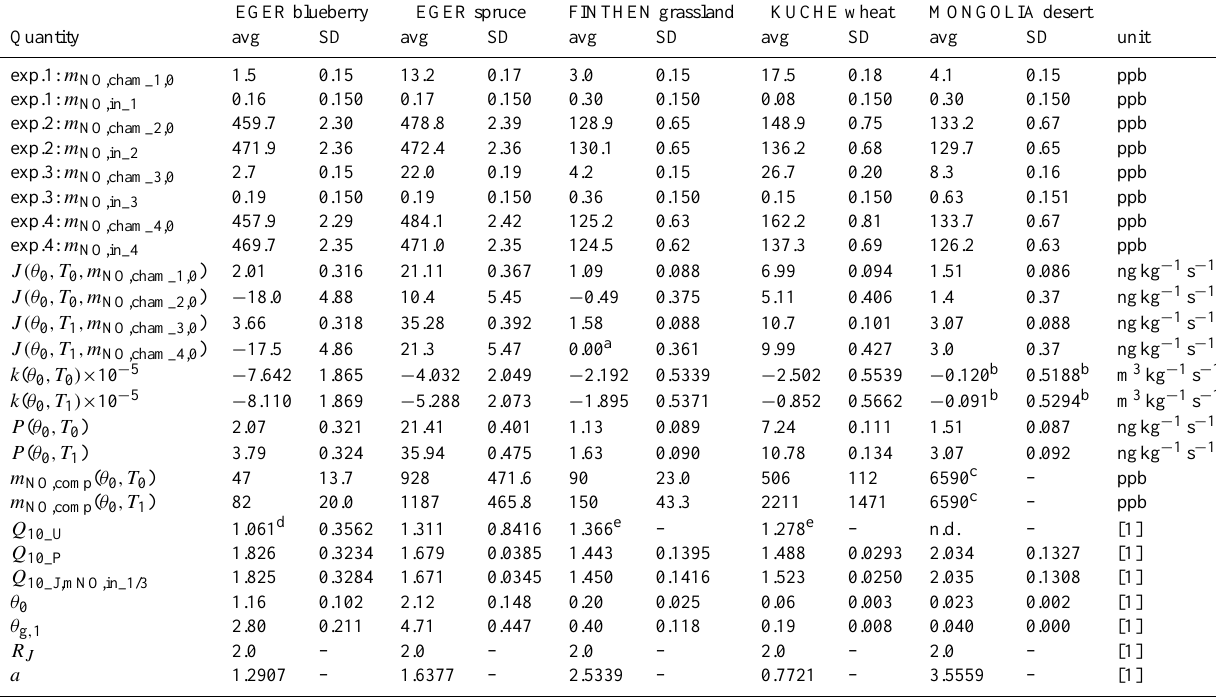
Table 2. Summary of results necessary to characterise NO consumption and NO consumption for the mid-latitude forest soils, mid-latitude grassland soil, and the arid and hyper-arid soils from Xinjiang and Mongolia used in this study. For the four experimental conditions exp. 1– exp. 4 (see Sect. 2), only those NO mixing ratios of the incoming ( m NO , in_x ) and chamber’s headspace air ( m NO , cham_x , 0 ) are listed which have been observed at θ g = θ 0 . J NO data have been calculated with Eq. (1), k NO data with Eqs. (12b) and (14b), P NO data with Eqs. (13b) and (15b), Q 10_ U ( = Q 10_ k ) data with Eq. (16), and Q 10_ P data with Eq. (17). NO compensation point mixing ratios, m NO , comp , are defined by the corresponding ratio of P NO and k NO . The value Q 10_ J, mNO , in_1 / 3 is defined by the ratio J NO (θ 0 , T 1 , m NO , cham_3 , 0 ): J NO (θ 0 , T 0 , m NO , cham_1 , 0